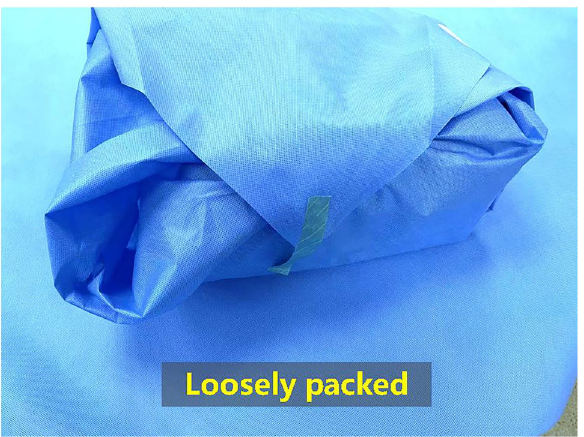
Figure 3. Loose device packaging.